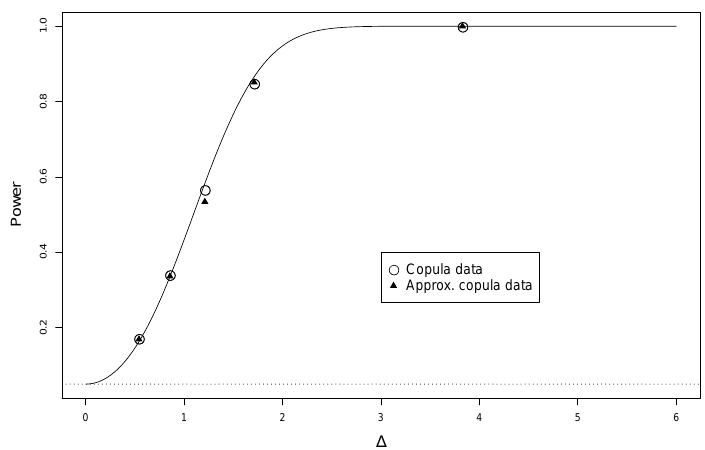
Figure 6: Asymptotic local power curve for the bivariate Frank copula with τ C = 0.75 and β C = 0.804 . Circles and tri- angles correspond to the empirical power for copula data and pseudo-observations, respectively, of sample sizes n = 100, 250, 500, 1000, 5000